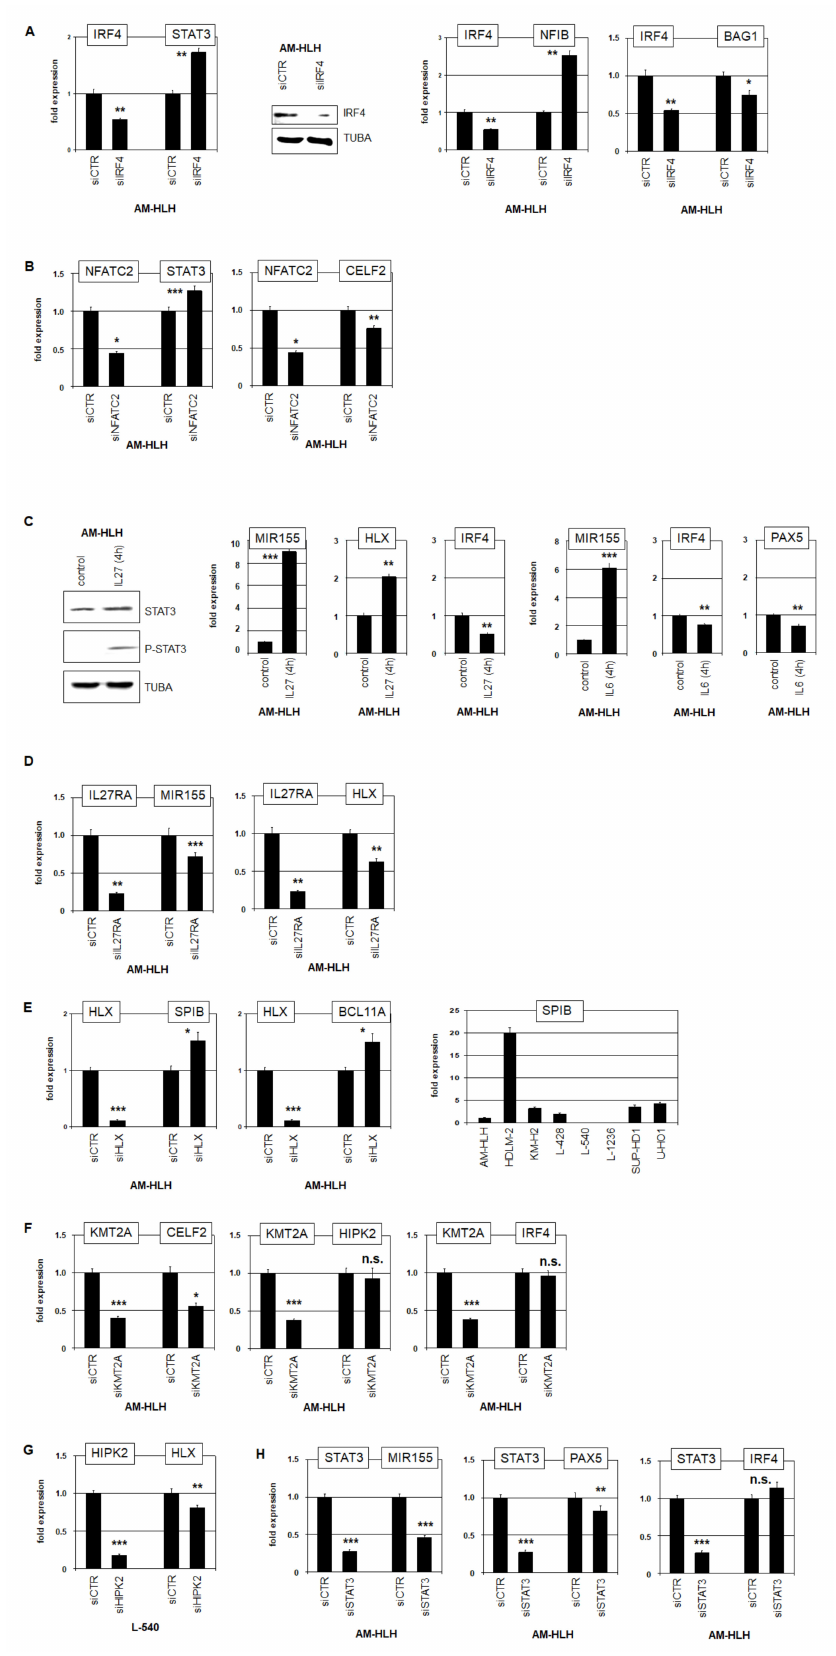
Figure 4. Knockdown and stimulation studies in AM-HLH and L-540. ( A ) SiRNA-mediated knock- down of IRF4 in AM-HLH resulted in elevated expression of STAT3 as analyzed by RQ-PCR (left).